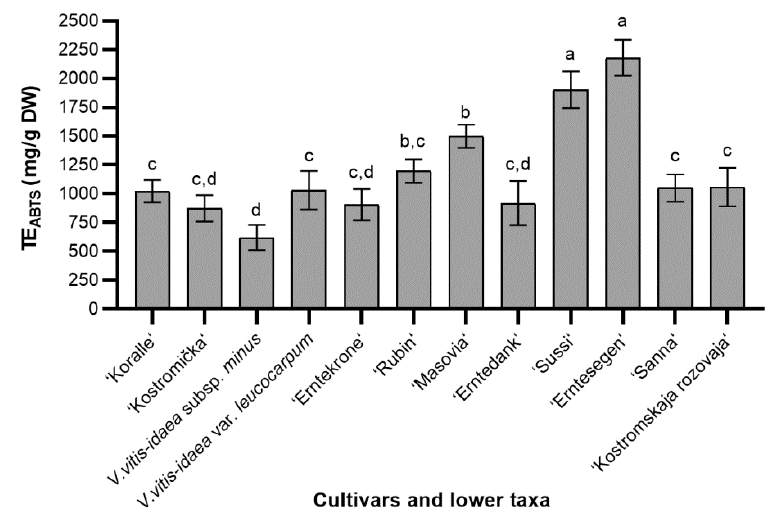
Figure 1. The radical scavenging activity of different cultivars and lower taxa of lingonberry leaves extracts; bars without the same letters (a, b, c, d) indicate statistically significant differences between the means ( p < 0.05).